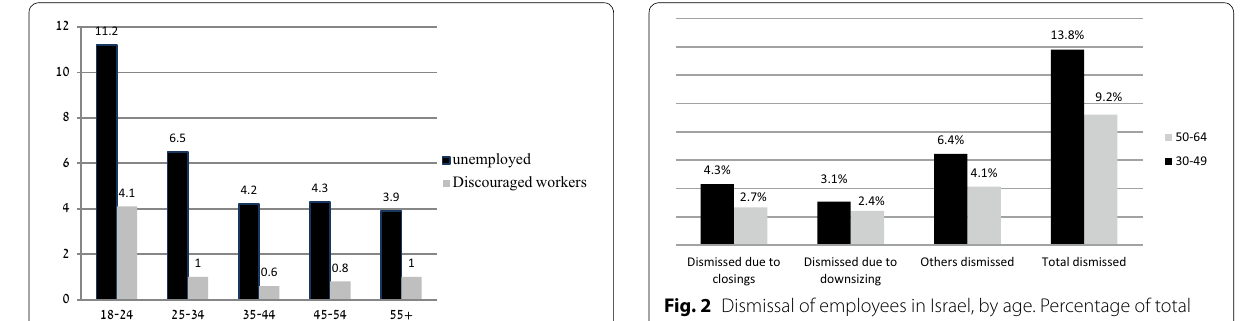
Fig. 1 Unemployed persons and discouraged workers as percent- ages of the civilian labor force, by age group (Bank of Israel 2011). We excluded those living outside settled communities or in institutions. The percentages of discouraged workers are calculated from the civilian labor force after including them in it (Source: Calculated by the authors by using data from the Labor Force survey of the Israeli